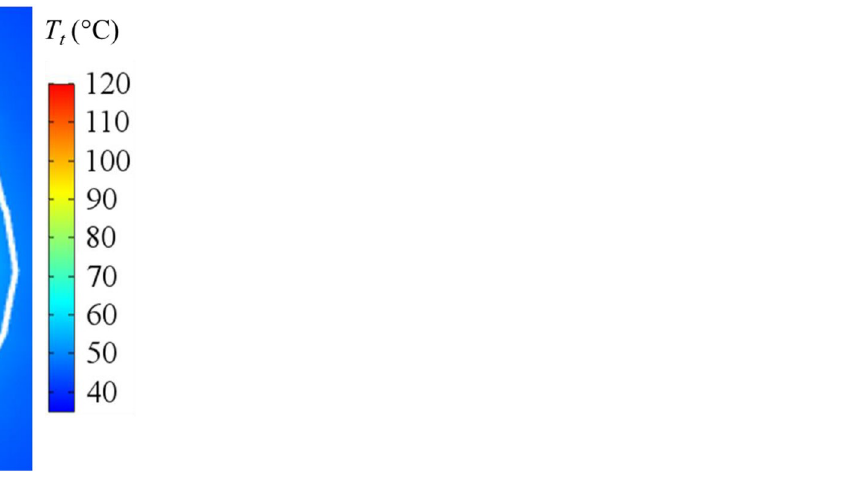
Figure 7. Tissue temperature distributions after 720 s of applying 90 V computed from LTNE model for ɛ = 0.3, a detail of the colder zone near the electrode. White line represents coagulation zone contour. The thicker black line identifies the position of the